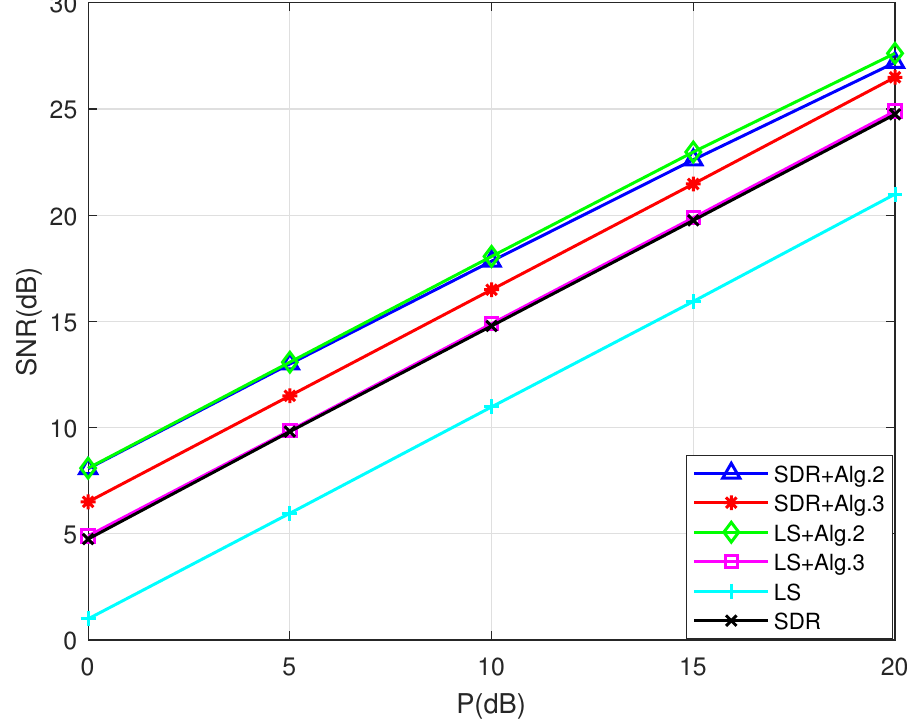
Figure 5. SINR performance comparison over the transmission power P with a fair number of reflecting elements ( N = 128). Here, M = 8 and K =